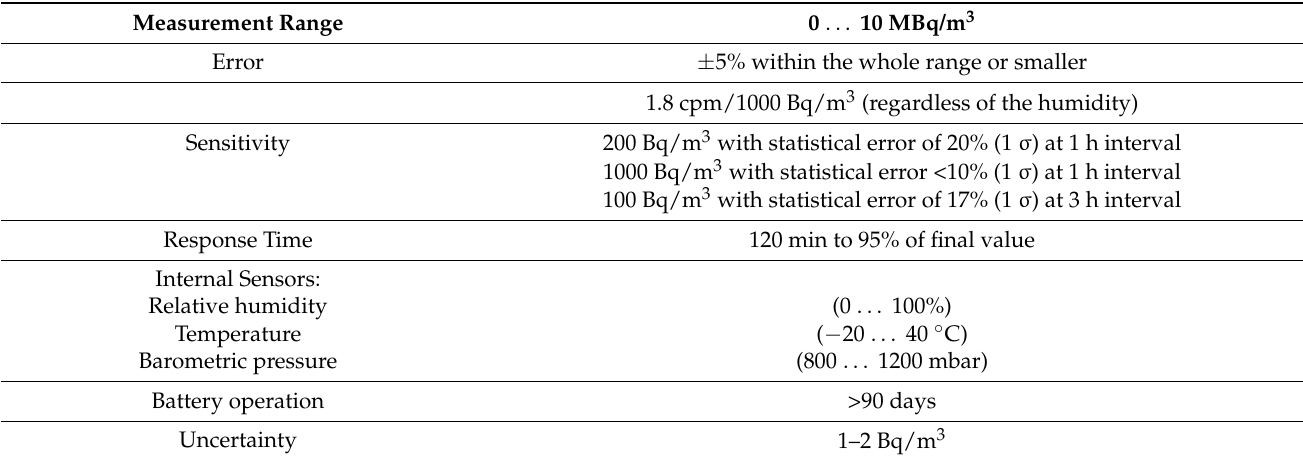
Table 1. Technical data (Radon-Scout PLUS Radon monitor, SARAD GmbH, Germany). Measurement